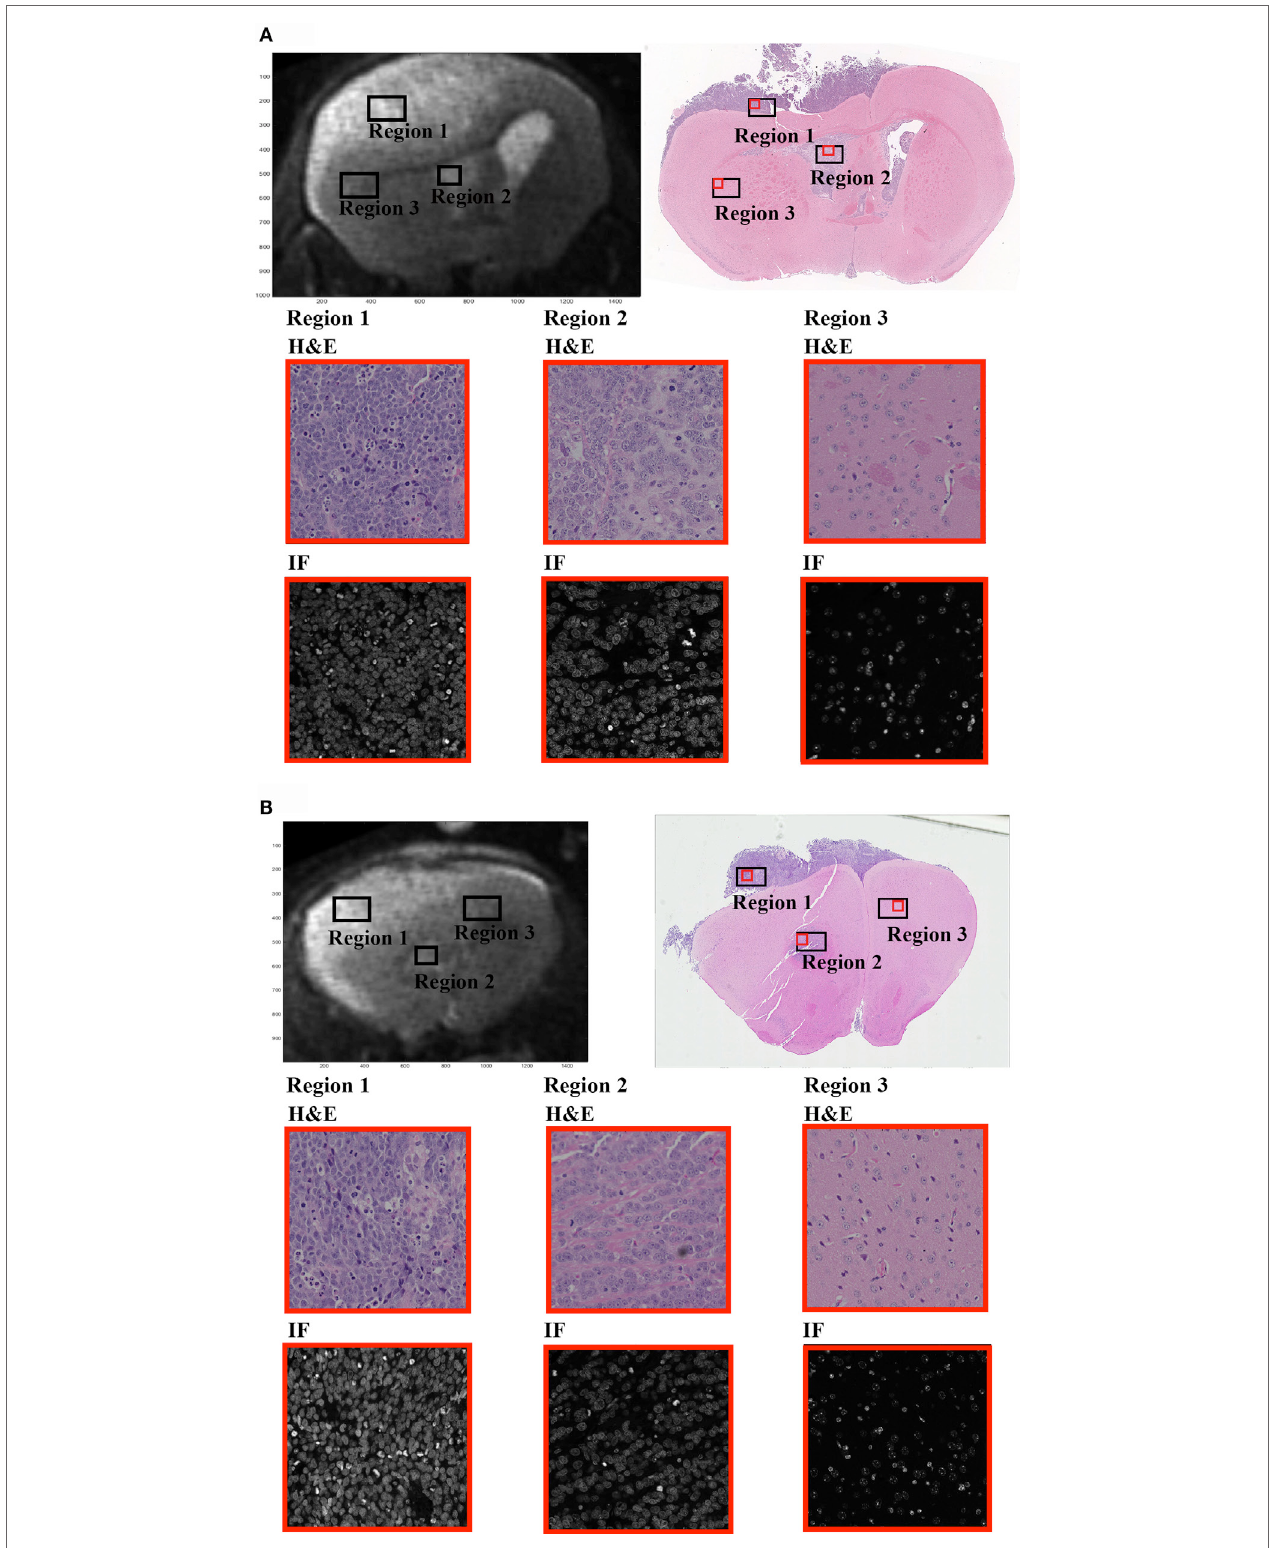
FigUre 1 | in the presented study, we have investigated the diffusion time ( Δ )-dependence on the DW-signal within three regions of interest (rOis) selected from Mri brain images of a single gBM xenograft mouse .